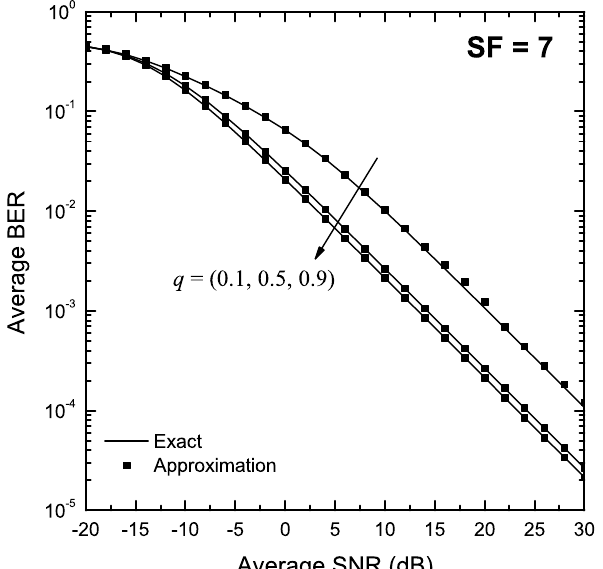
Figure 7. BER of LoRa systems operating in the presence of Hoyt fading as a function of the SNR, γ , for SF = 7 and various values of q .